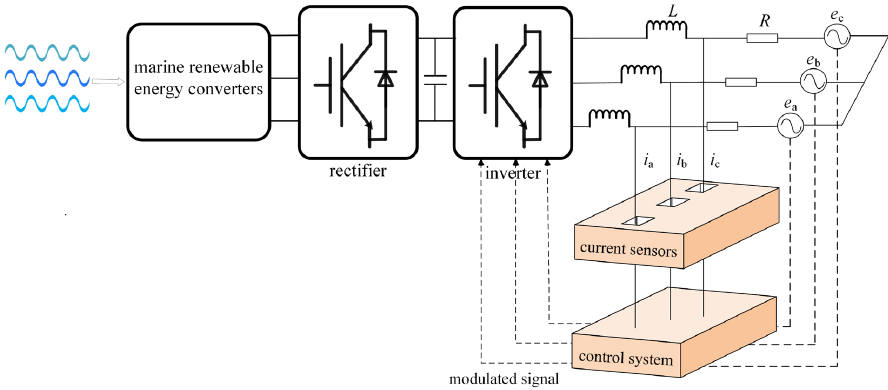
Figure 1. Four working states of the H-bridge: ( a ) forward conduction; ( b ) reverse conduction; ( c ) forward bypass; ( d ) reverse bypass .